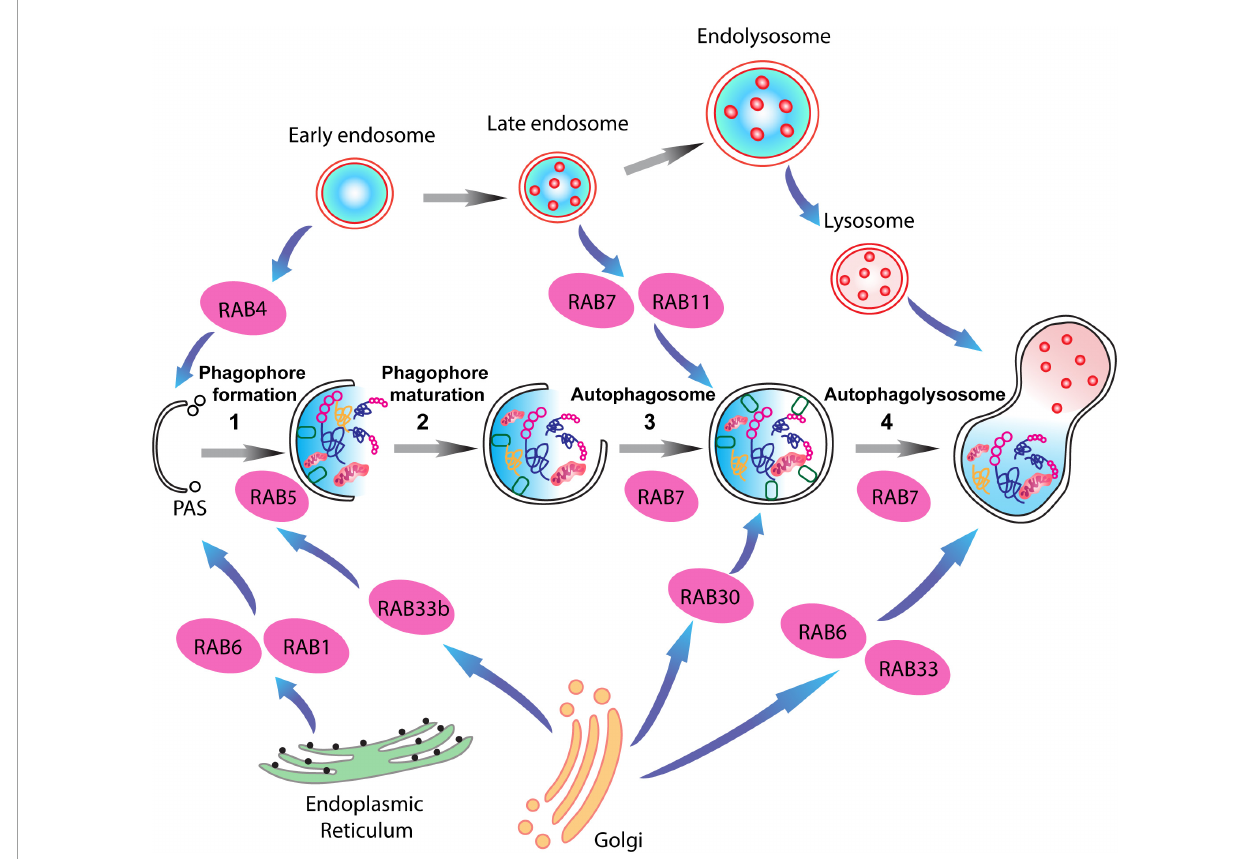
FIGURE3 RAB proteins involved in different steps of the autophagy-lysosome pathway (ALP). Schematic representation of RAB GTPases and their binding partners in the ALP. RAB1, RAB6, and RAB4 are important for the formation of the pre-autophagosomal structure (PAS) providing membrane sources for the initiation of the autophagy pathway, while RAB5, RAB30, RAB33 are involved in autophagosome maturation together with RAB7, which is also involved in the fusion of the autophagosomes with late endosomes.